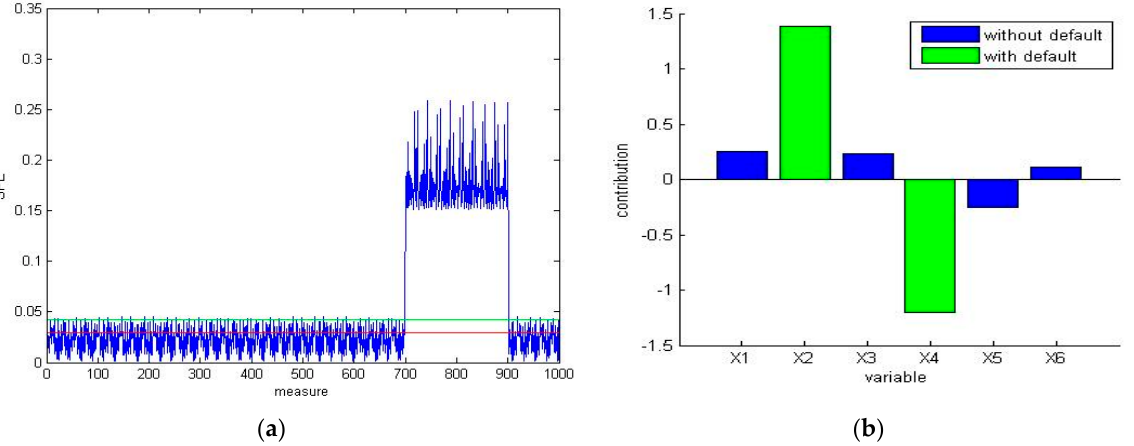
Figure 7. SPE fault detection ( a ) and isolation ( b ) of reconstructed data using the multiway kernel PCA.